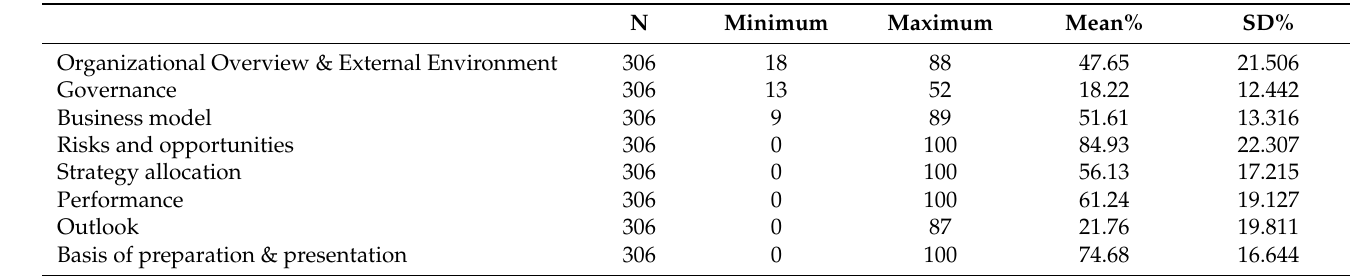
Table 3. Descriptive analysis of the dependent variables (IR elements disclosure).